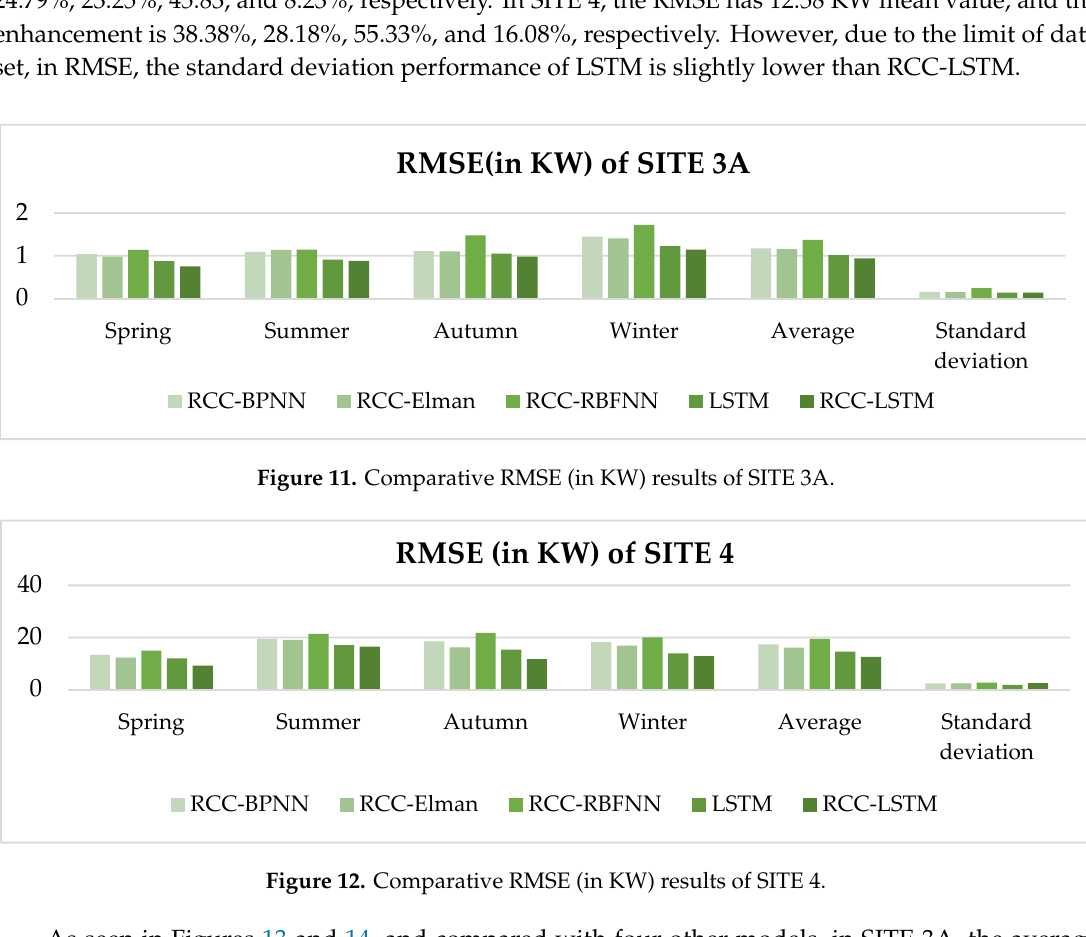
Figure 10. Forecasting result curve by different models for random days in SITE 4.